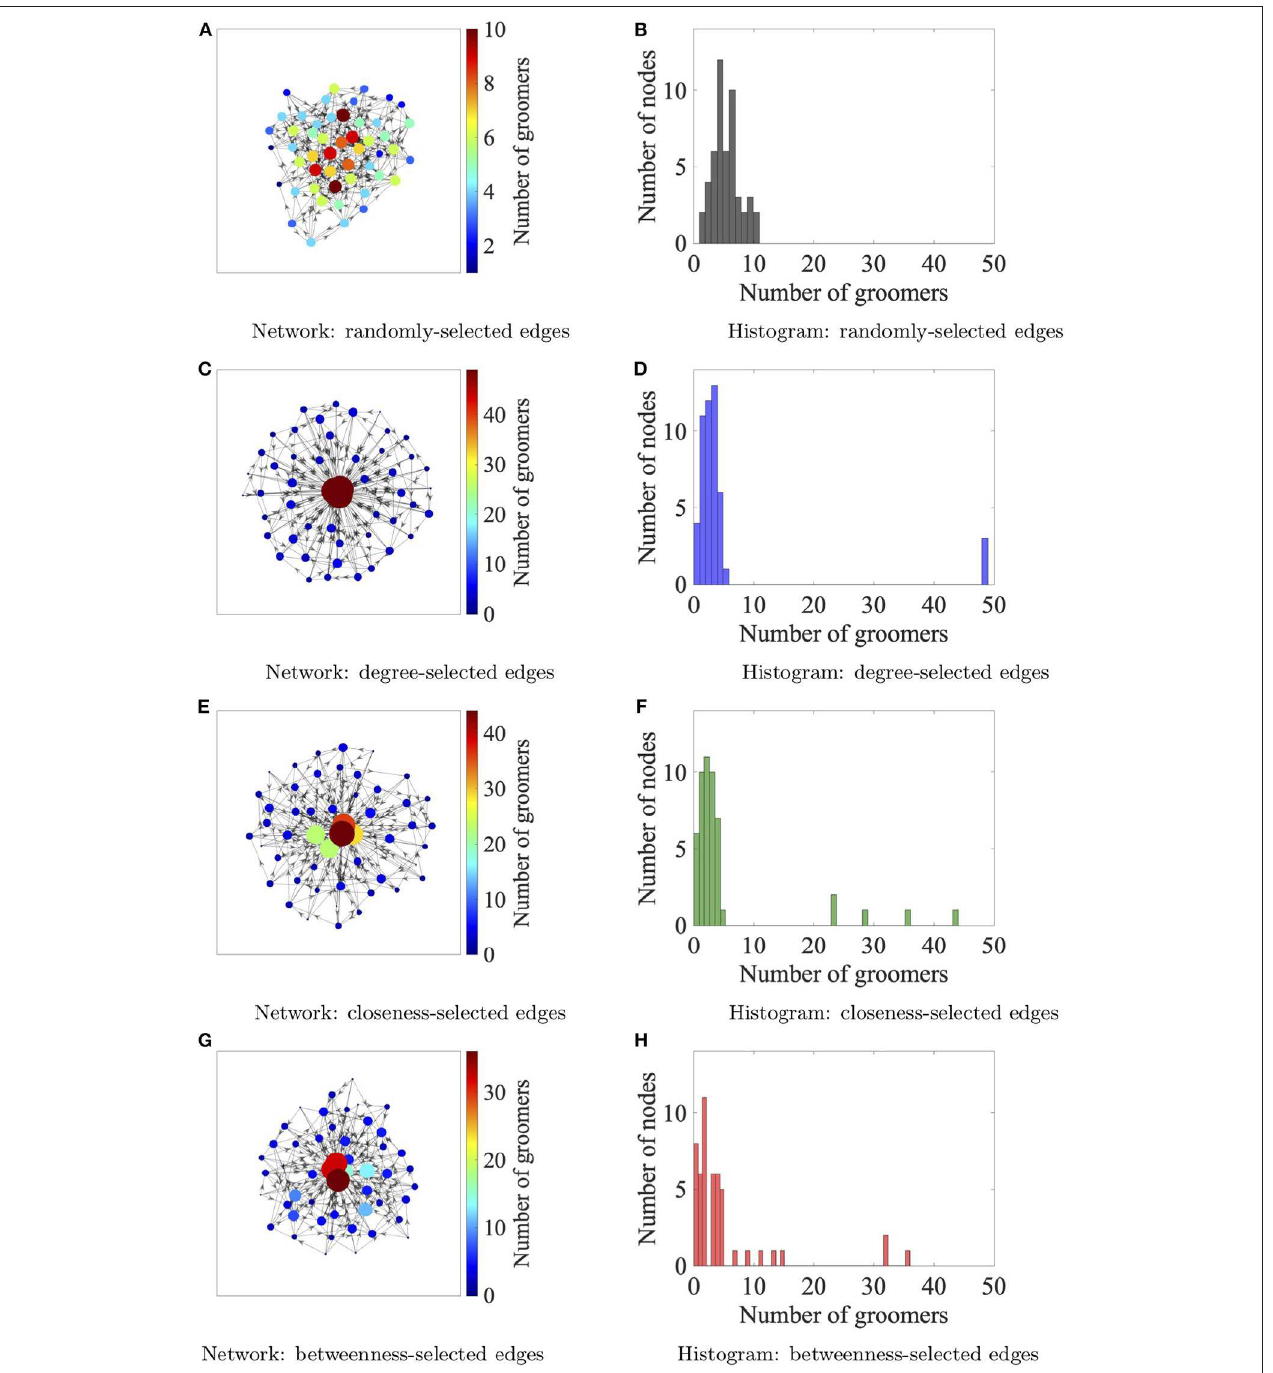
FIGURE 2 | Network configurations after 150 iterations for the four neighbor affiliation strategies, from top to bottom: random (A,B) , degree (C,D) , closeness (E,F) , and betweenness (G,H) . One realization of each network are depicted in the left column, where the in-degree of each vertex is reflected in its size as well as color. The distribution of the in-degrees of the nodes in each network, which represents the number of groomers of each node, is shown in the right column. By looking down the right column, we see that the networks organized by the degree affiliation strategy are the most structured in the sense that there are three core nodes having exactly 49 groomers, and the rest (periphery nodes) have < 5 groomers on average. The networks structured by closeness and betweenness affiliation strategies have a few nodes with many groomers, while the network structured by random affiliations has no nodes with more than 10 groomers.